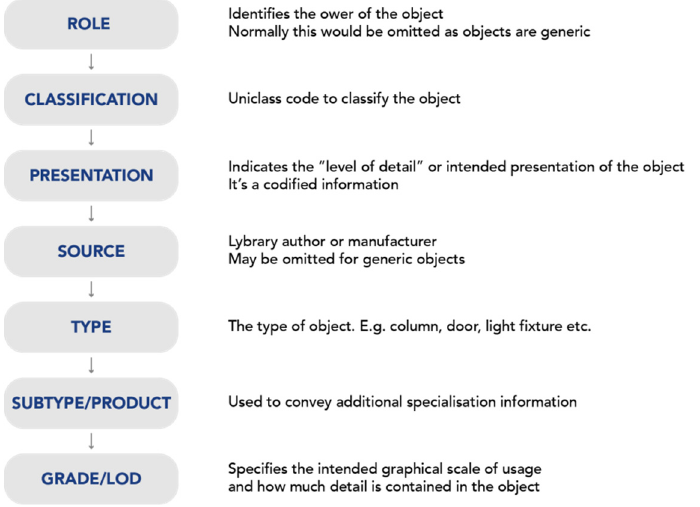
Figure 2. Nomenclature scheme for BIM element. AEC (UK) BIM Technology Protocol.